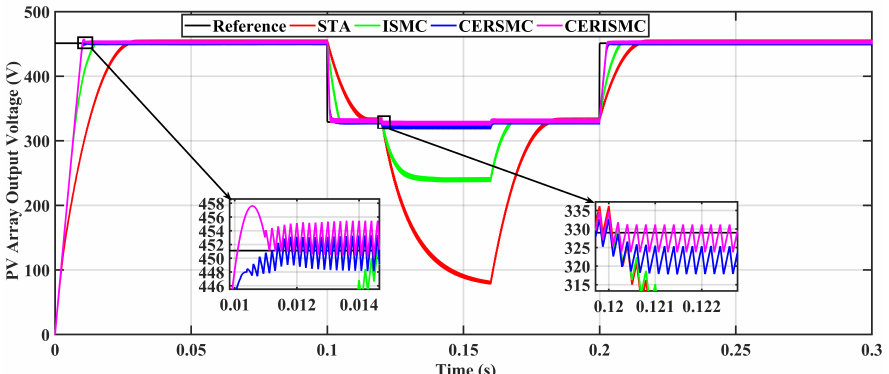
Figure 9. PV array output voltages under varying irradiance, temperature, load and a charging